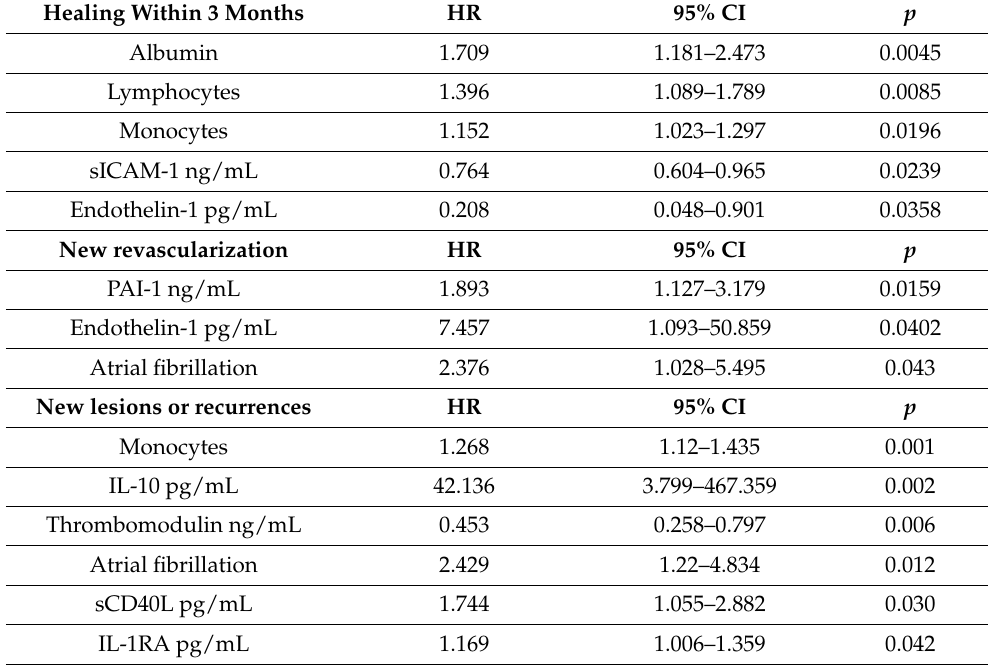
Table 3. Cox proportional hazards regression variables in a univariate model for each of the three endpoints. Results are reported as hazards ratios (HR) and associated 95% confidence intervals (CI). Healing Within 3 Months HR 95% CI